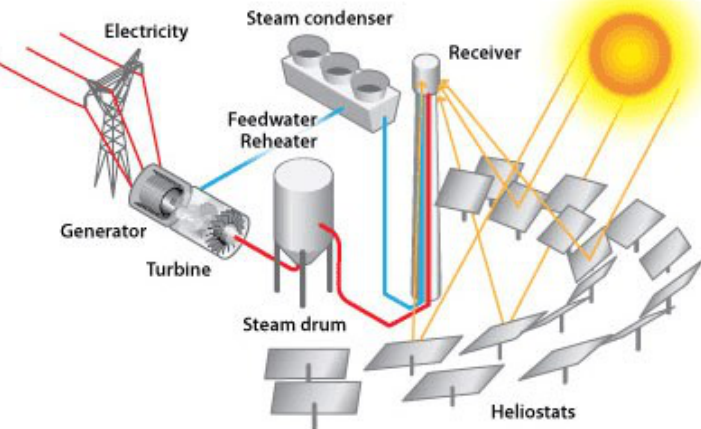
Figure 2. Heliostat power tower power station. Source: O ffi ce of Energy E ffi ciency and Renewable Energy [26]. (i) Mirror array focuses sunlight to a surface on the power tower. (ii) Heat transfer fluid is passed through the surface. (iii) Heated fluid is used to drive steam turbine generators. (iv) Fluid can be stored to generate power when the sun is not visible.